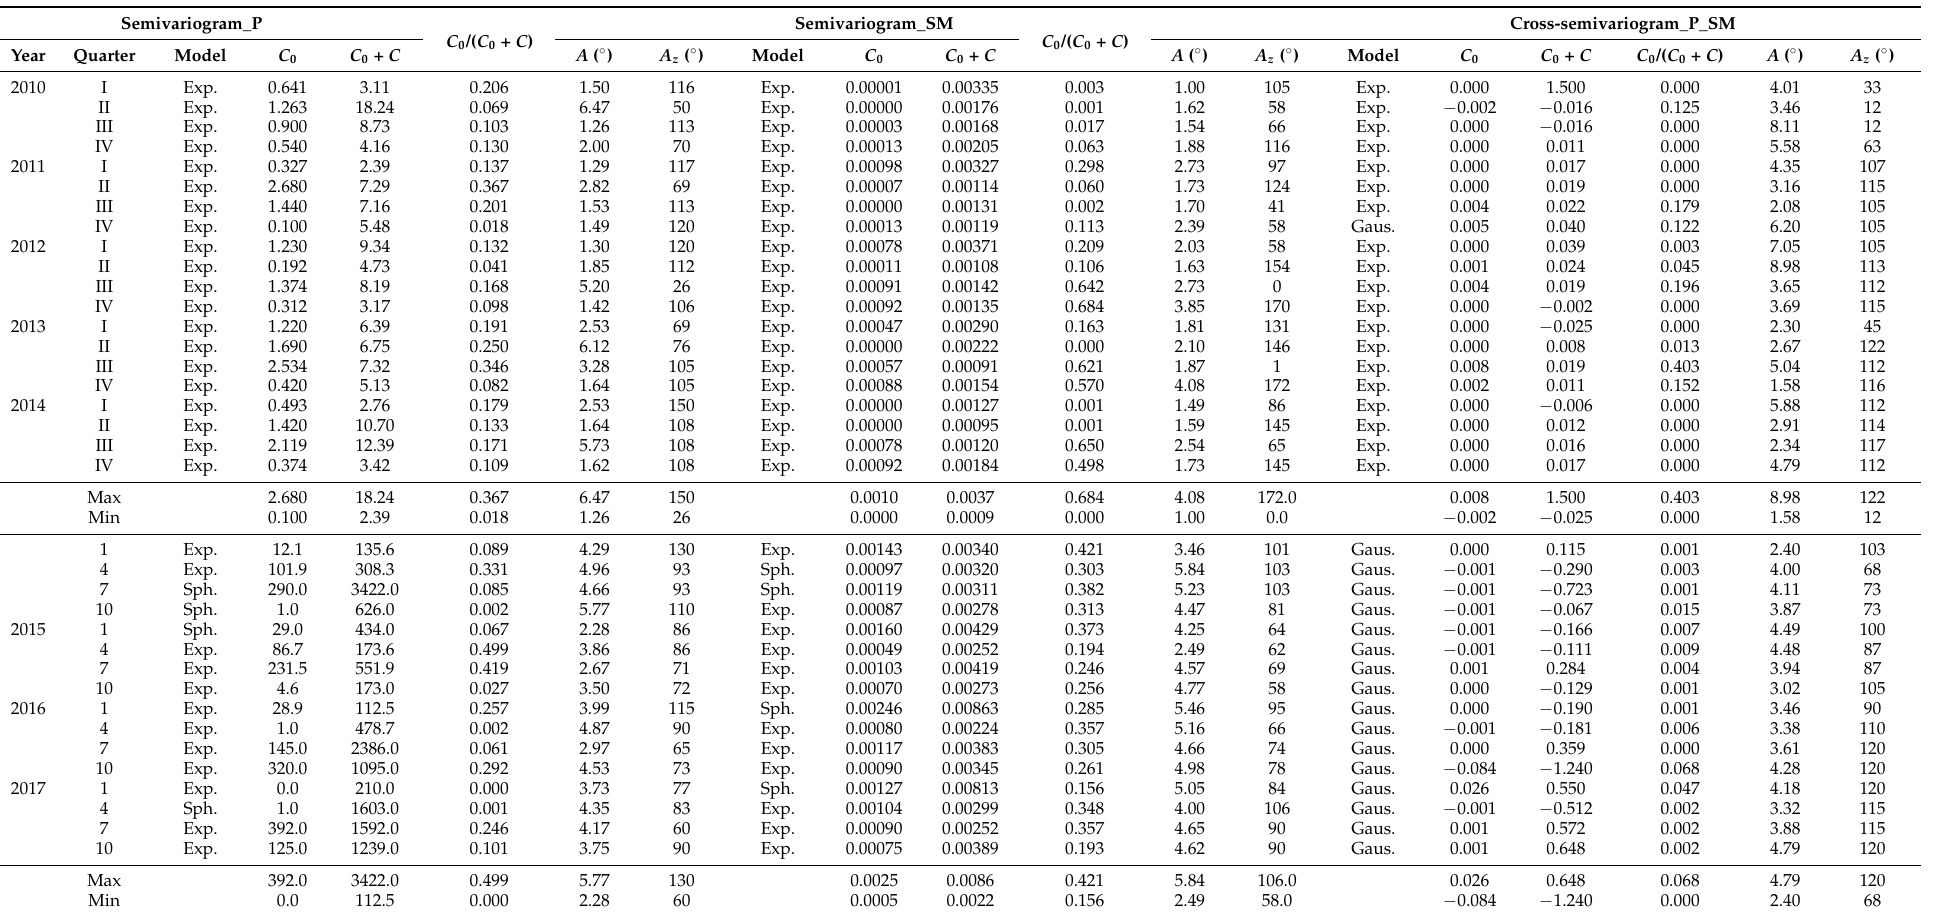
Cross-semivariogram_P_SM